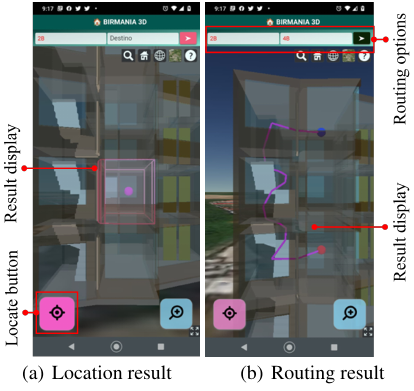
Figure 1. Indoor navigation system application